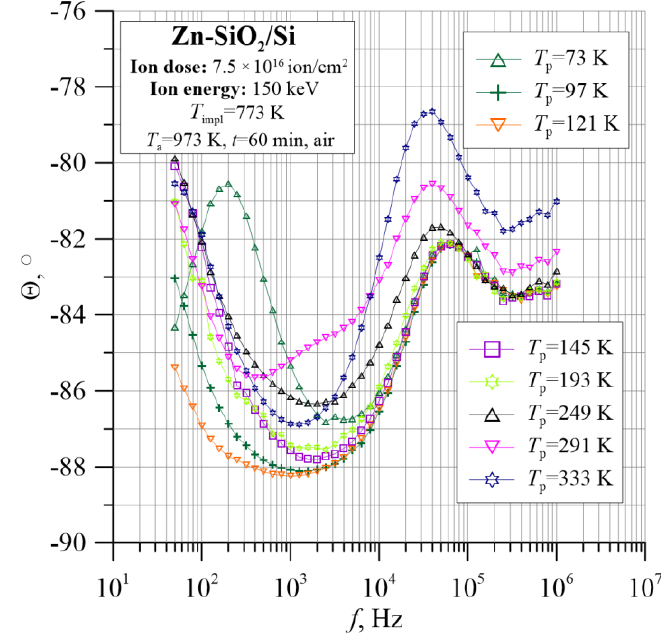
Figure 16. Temperature –frequency dependence of phase shift angle θ( f , T p ) for the Zn-SiO 2 /Si nanocomposite prepared under “hot” implantation conditions (150 keV, 7.5 × 10 16 ion/cm 2 , T impl = 773 K) after annealing.